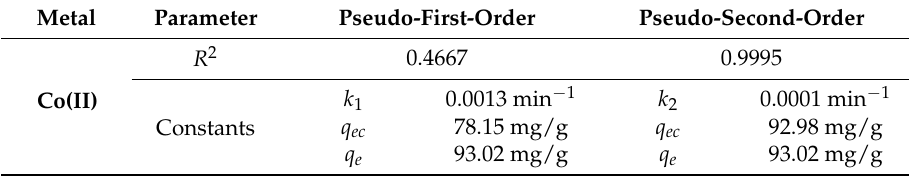
Table 2. Kinetic parameters for Co(II) adsorption onto LMT.